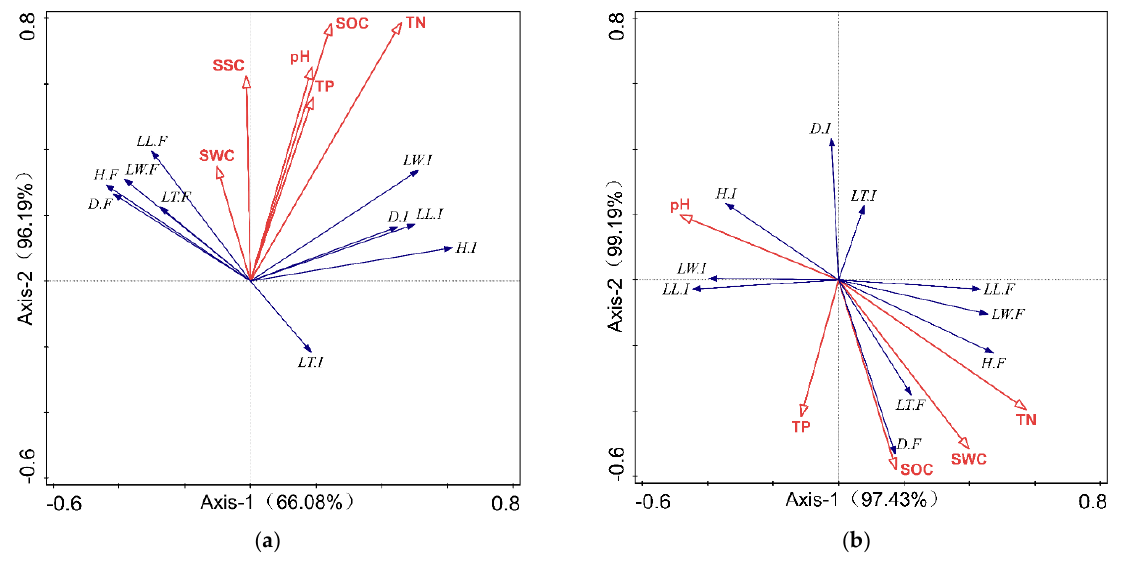
Figure 3. RDA of inter- and intraspecific variation in plant community and soil physicochemical factors under different soil water gradients. ( a ) High moisture gradient; ( b ) low moisture gradient. When the angle is between 0° and 90°, a positive correlation exists between plant functional trait variation and soil environment; between 90° and 180°, the correlation is negative; at 90°, no obvious correlation exists. Red arrows represent soil physicochemical factors, and blue arrows represent inter- and intraspecific trait variation. Table 4. Soil factor RDA: explanation rates of plant functional trait variation and environmental variables under different soil water gradients.